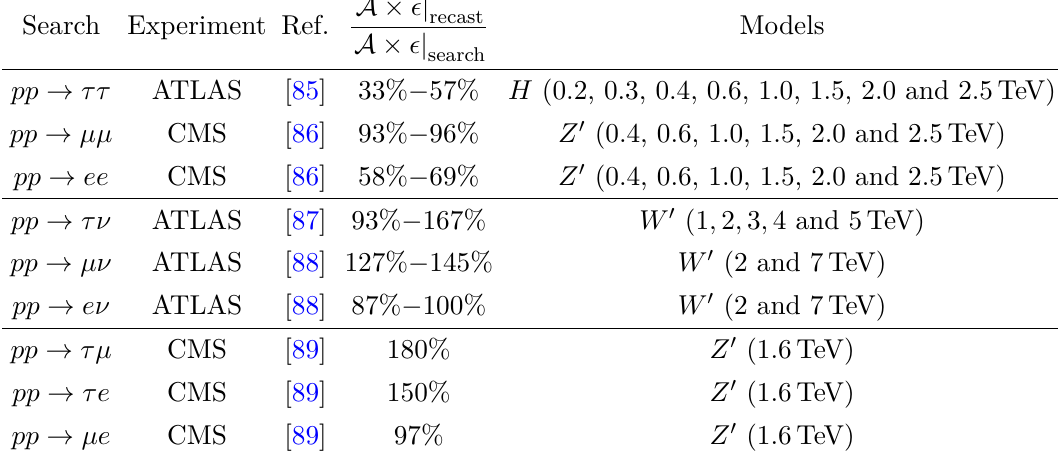
Table 5. Validation of our simulation of the New Physics signal used as a benchmark in the experimental analysis. In the fourth column, we compare against the acceptance × efficiency ( A × (cid:15) ) provided by the experimental